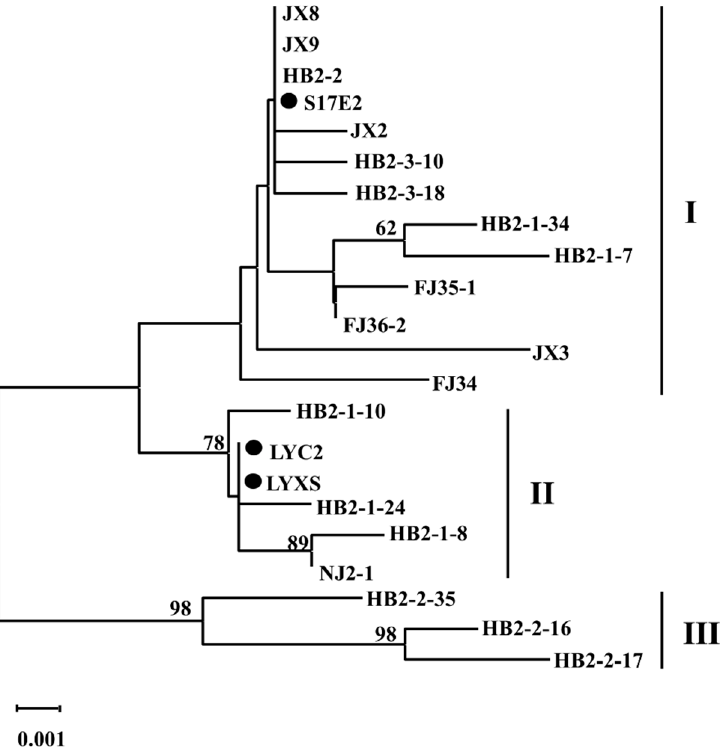
Figure 5. Unrooted NJ phylogenetic trees generated from the nucleotide sequences of partial S segment of ARWV-2. The corresponding sequences of three isolates S17E2, LYC2, and LYXS were included in the assay.